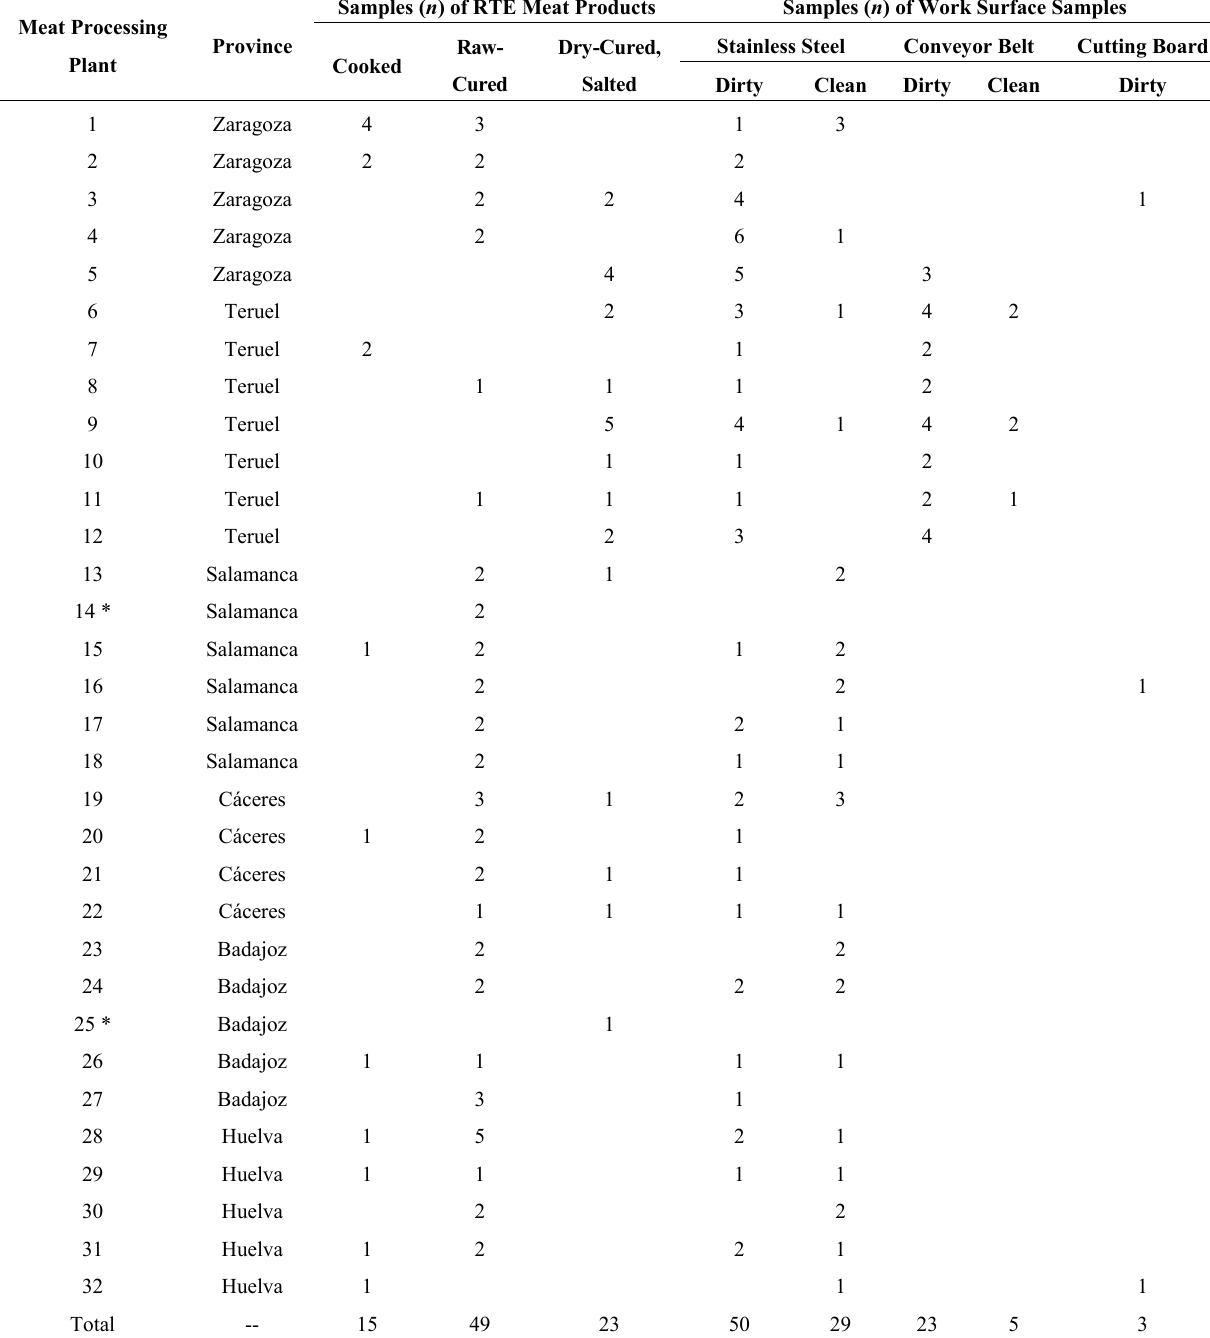
Table 1. Number of samples ( n ) of ready-to-eat (RTE) meat products and work surfaces from each meat processing